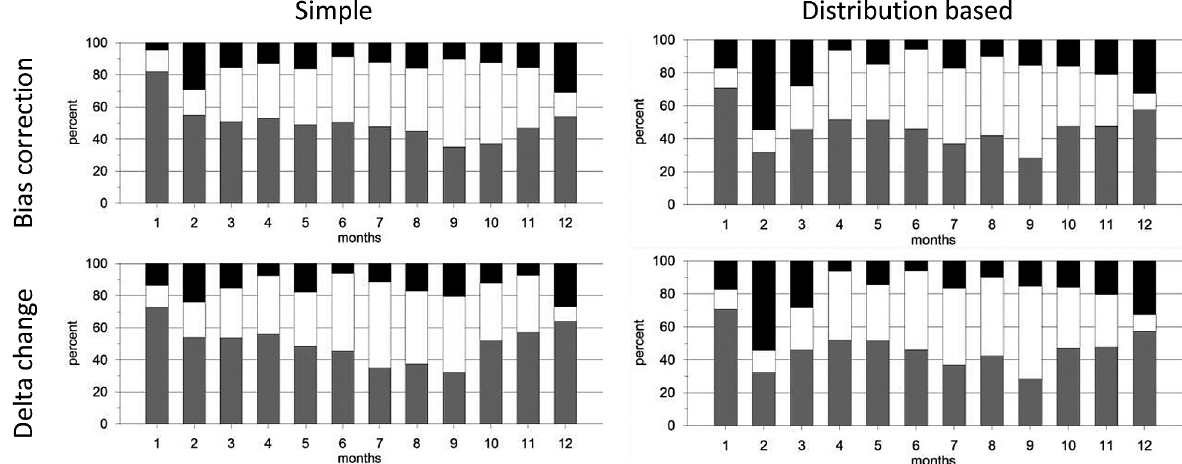
column.Fig. 5. Frequencies of improvements (grey), no change (white) and worsening (black) after corrections made by different methods for 10th percentile. Bias correction methods in the upper raw and delta change methods in the lower raw, simple variants in the left column and distribution based variants in the right